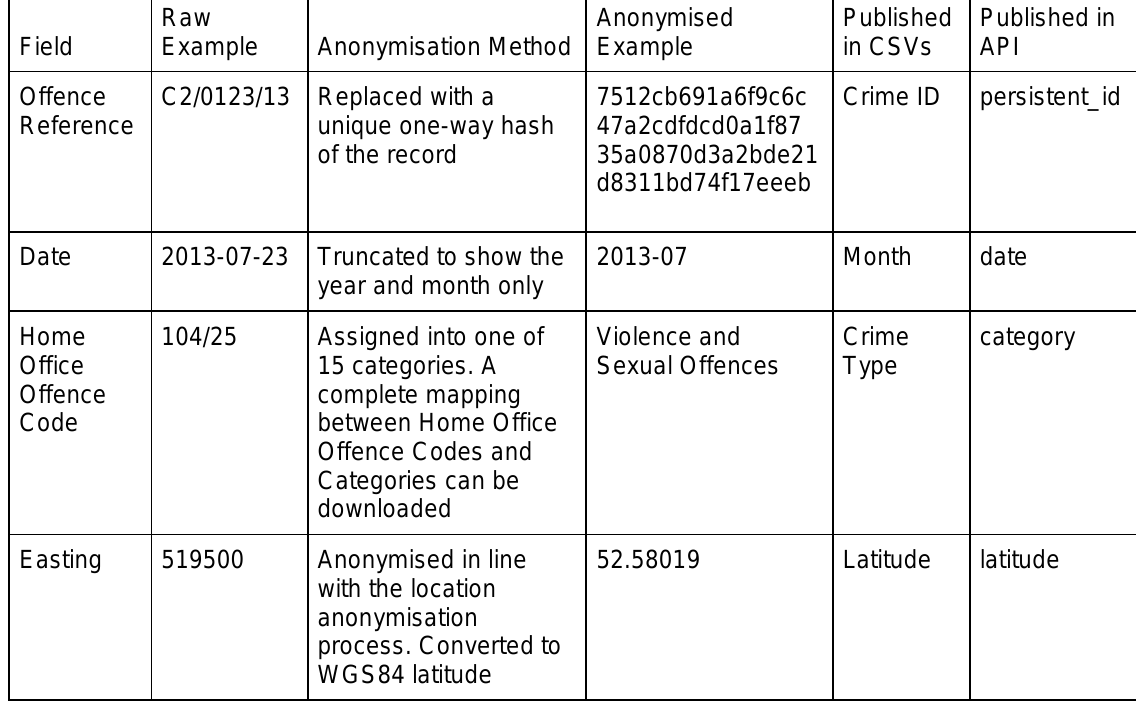
Table 1: Anonymisation process for police.uk data 22